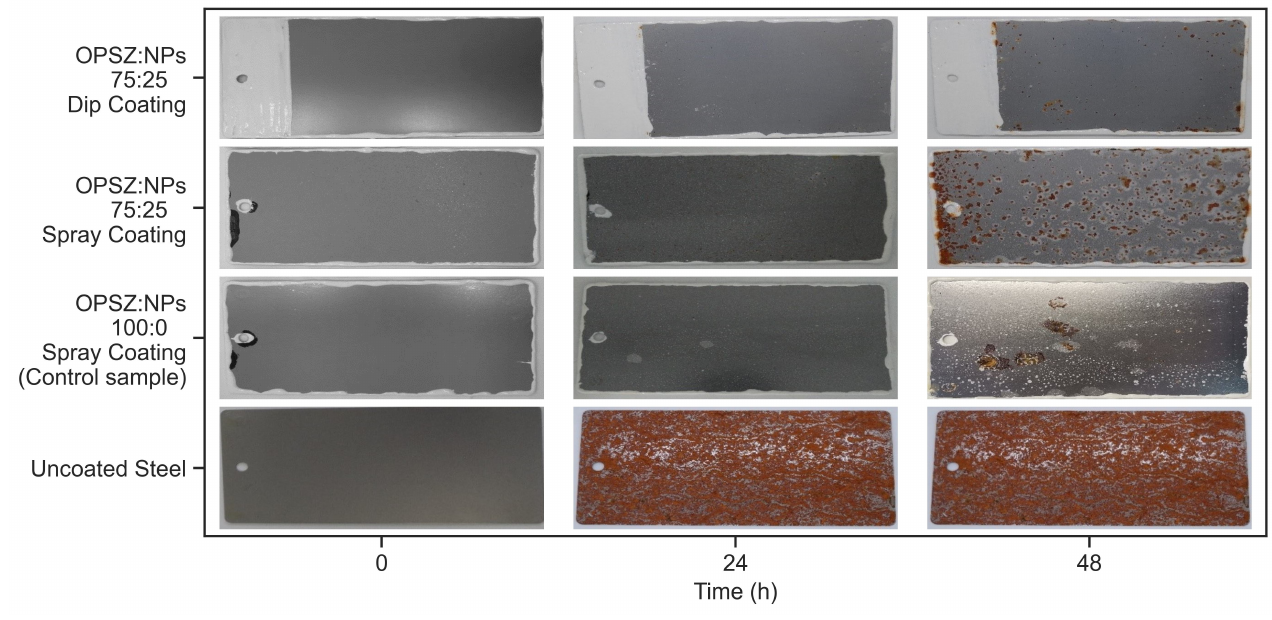
Figure 8. Evolution of coatings on steel during salt spray test.